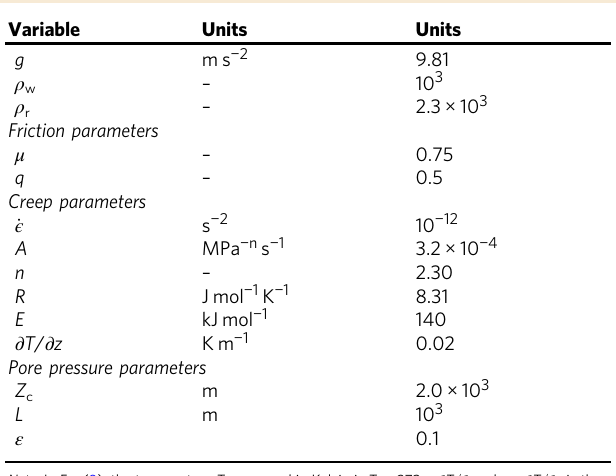
Table 1 Model parameter values for the strength envelope shown in Fig.